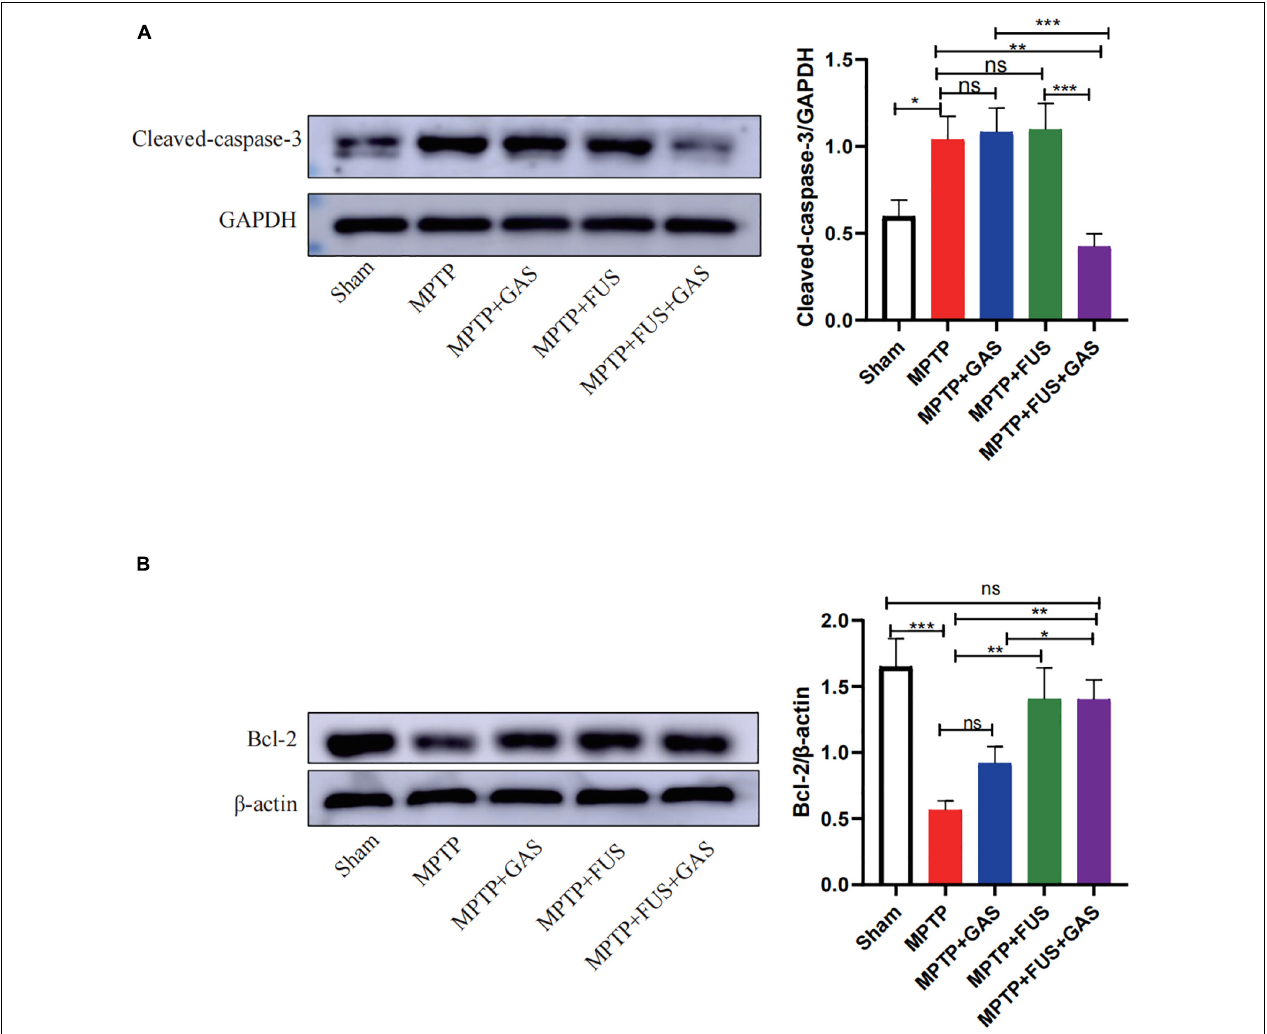
FIGURE 5 | (A) Changes in the expression of cleaved-caspase-3 in the left striatum of mice in each group. (B) Changes in the expression of B-cell lymphoma 2 (Bcl-2) protein in the left striatum of mice in each group. Compared to MPTP group, * P < 0.05; ** P < 0.01; *** P < 0.001, no significance (ns), P > 0.05. One-way ANOVA with LSD test; n = 5; mean ±